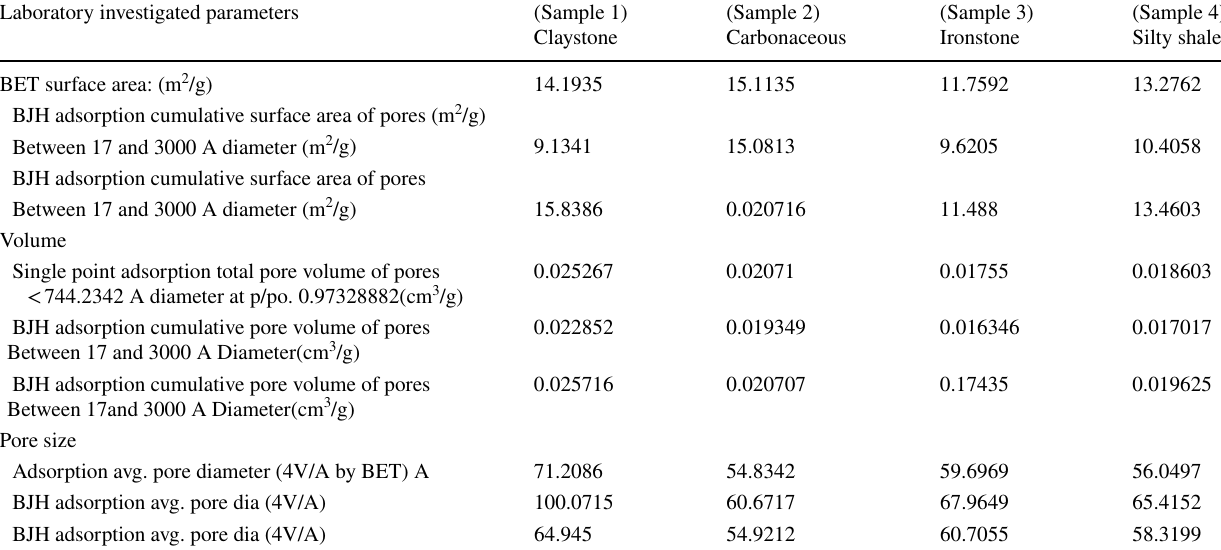
Table 3 Summary results of BET analysis of shales of Barren Measures formation Laboratory investigated